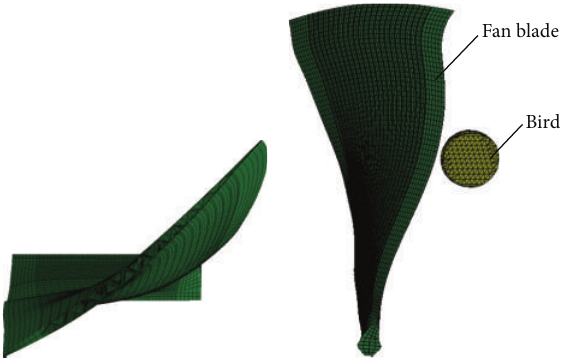
Figure 10: The bird-strike model for hollow fan